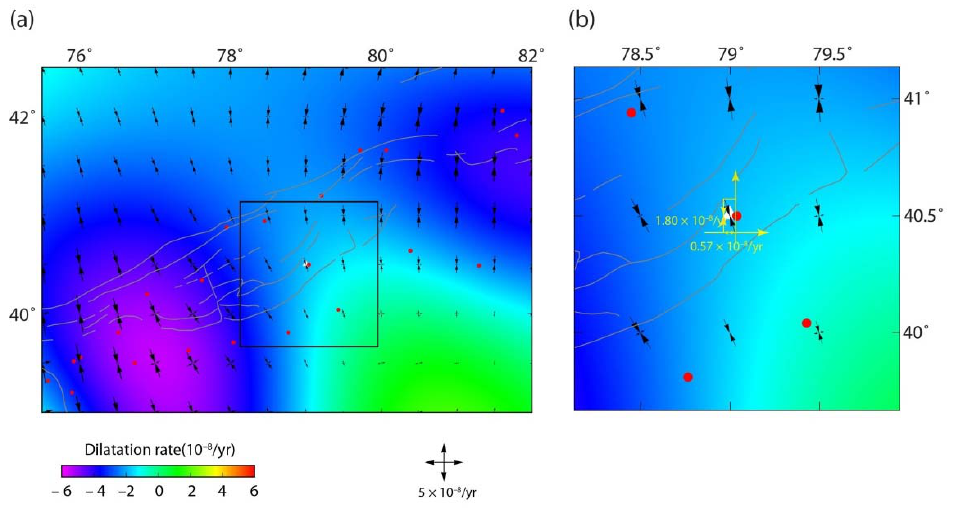
Figure 4. ( a ) Continuum strain field of the Atushi–Kalpin Thrust Zone derived from interpolated GPS velocities. The dilatation rate is in color, while the principal strain rates are denoted as vector pairs. ( b ) Strain plot for the Kalpin Apparent Resistivity Observatory, showing values for the N–S and E–W components.